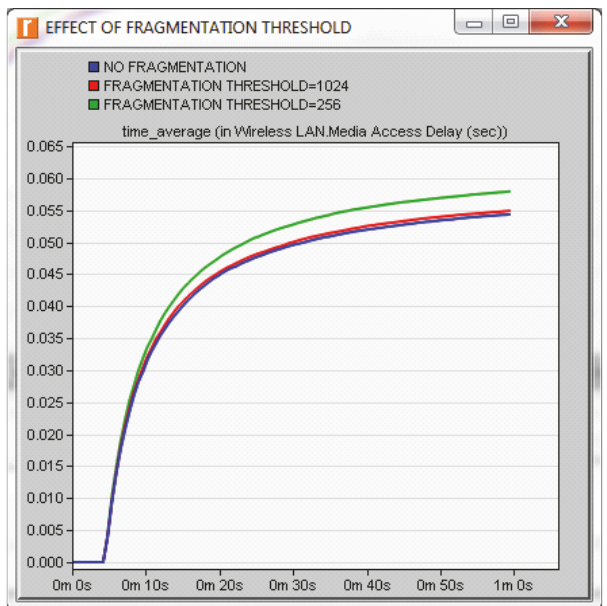
Figure 15: WLAN media access delay with different fragmentation thresholds and without fragmentation.